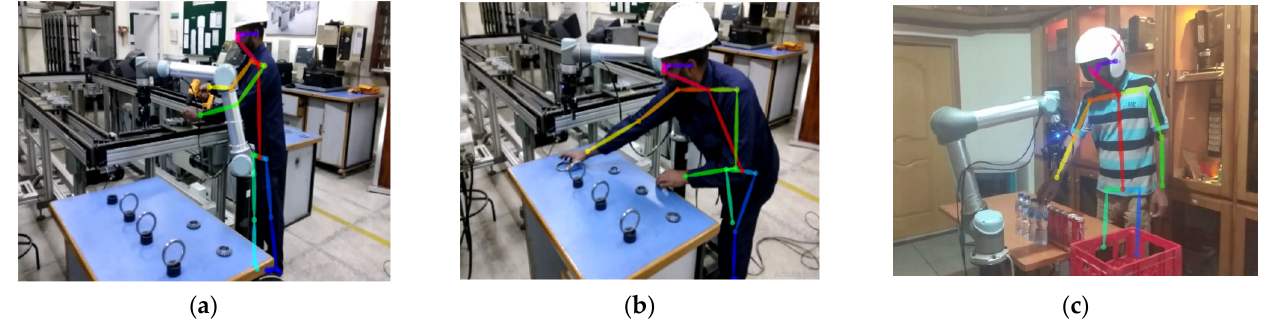
Figure 7. Detection of specific poses through pose detection algorithm, ( a ) pose while interference in assembly; ( b ) pose while interference in picking of gears; ( c ) pose while interference in picking of beverages.